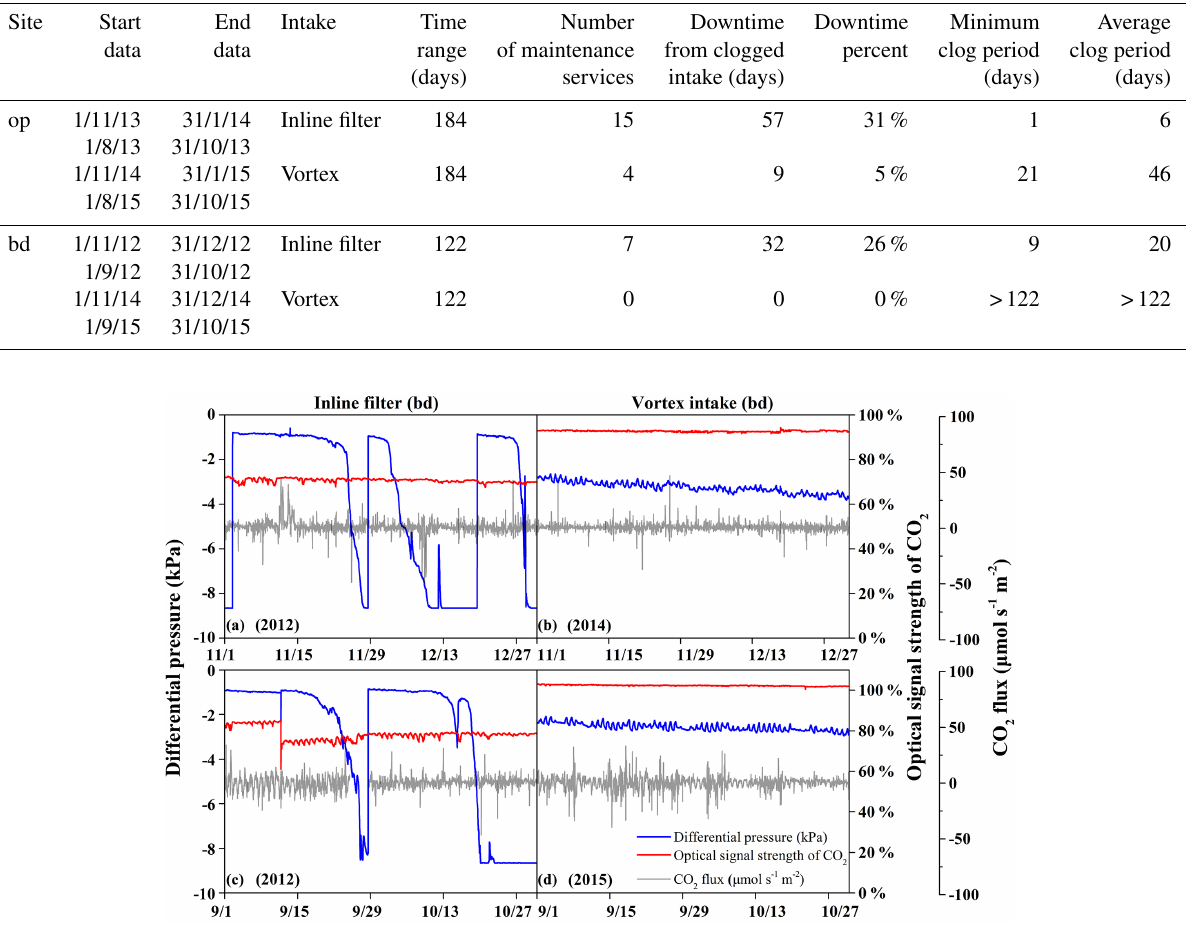
Table 1. Summary of field maintenance notes for the EC155 with vortex intake compared to the EC155 with an inline filter at Olympic Park (op) and Badaling Farm (bd), Beijing, China. The time range includes periods of both high and low incidence of haze. Clog period is the number of days for the differential pressure to reach ± 7kPa after installing a new filter.